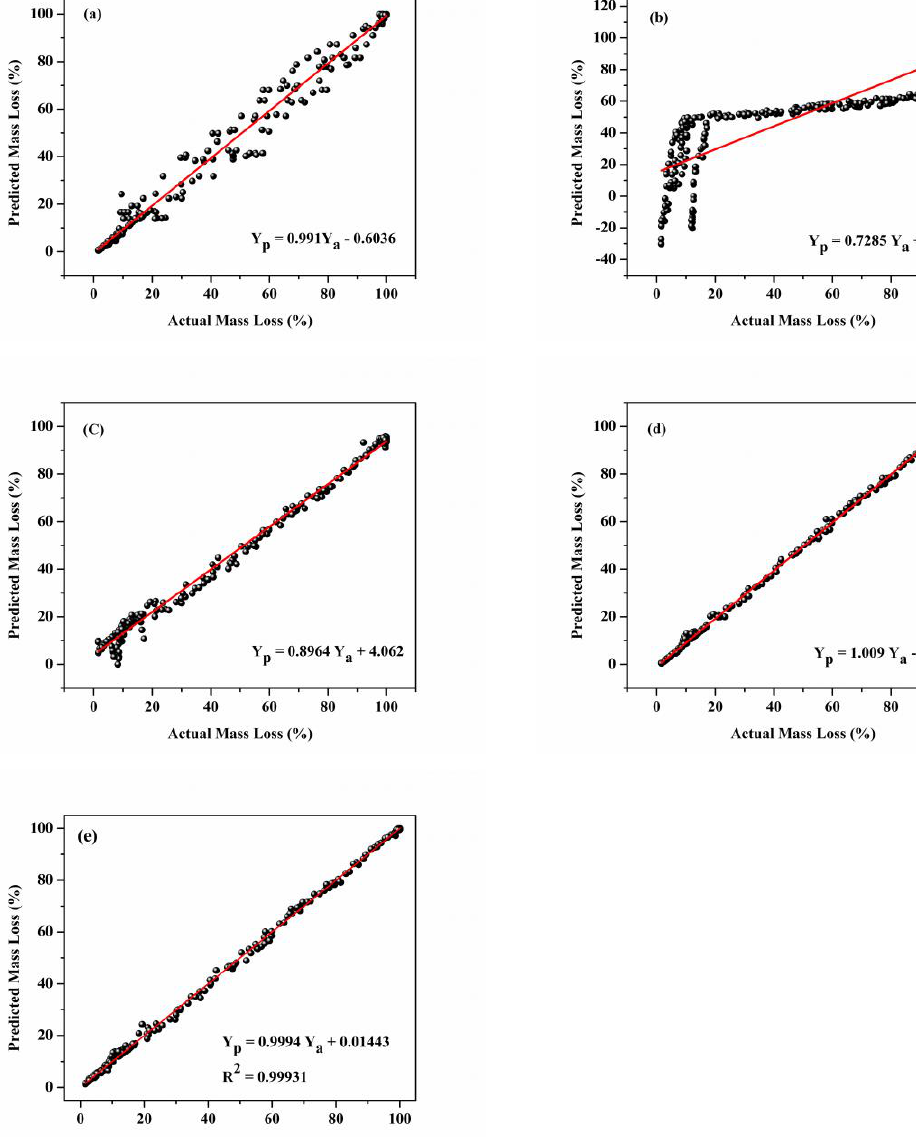
Figure 12. Regression plots of tested data for developed machine learning models ( a ) Random Forest ( b ) Linear regression ( c ) SVM ( d ) Gaussian process regression ( e ) ANN.